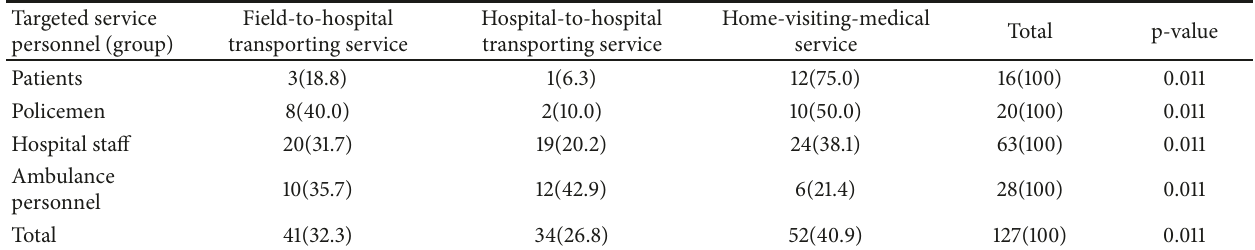
Table 2: Emergency ambulance services costs (units: frequency, %).